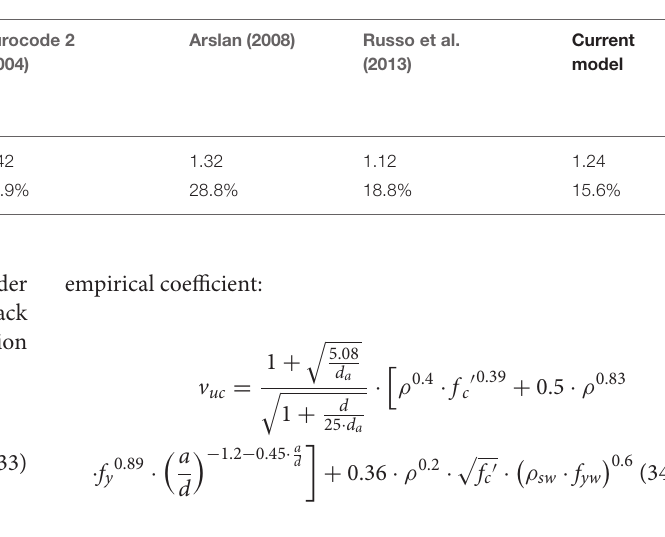
TABLE 3 | Shear strength